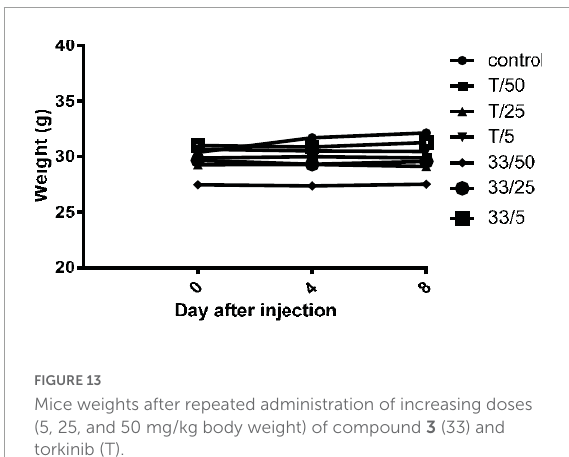
FIGURE13 Mice weights after repeated administration of increasing doses (5, 25, and 50 mg/kg body weight) of compound 3 (33) and torkinib